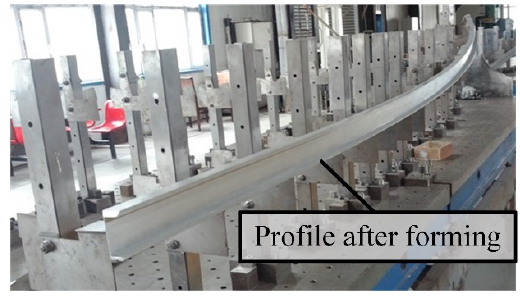
Figure 13. Experimental workpiece.